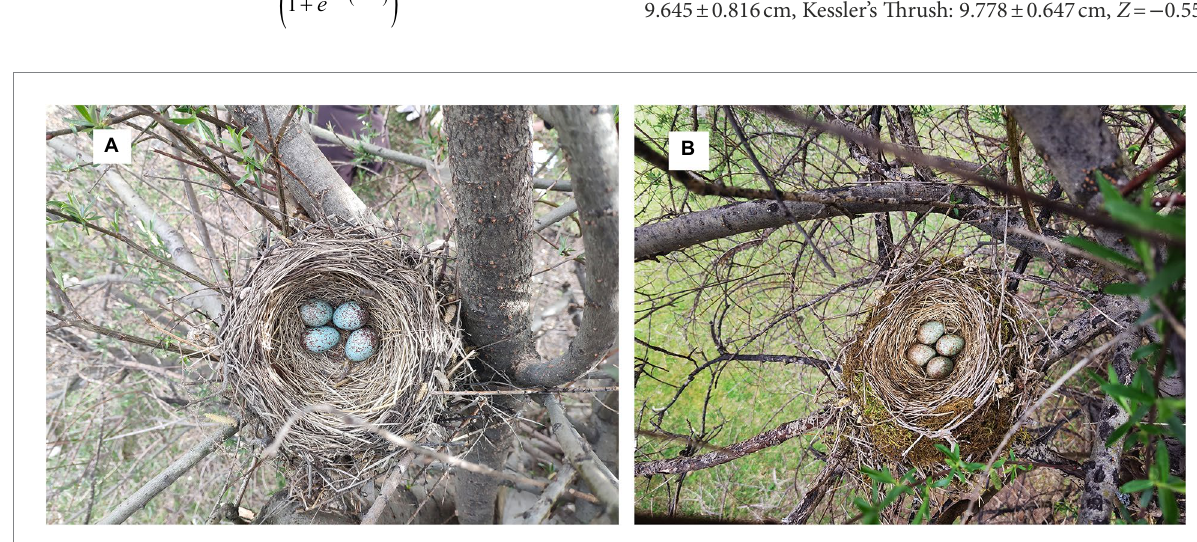
FIGURE 2 (A) Chestnut Thrush eggs and nests. (B) Kessler’s Thrush eggs and